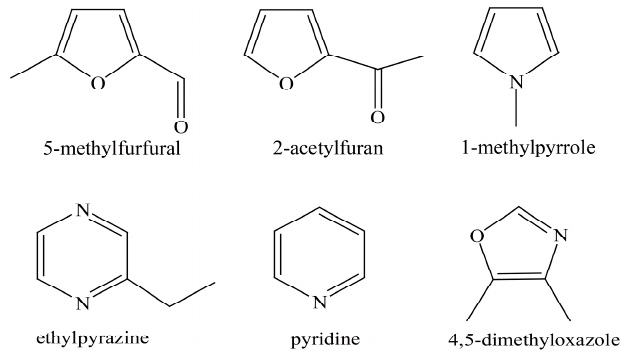
Figure 2. Structures of some representative compounds identified in the glucose/glycine melanoidins [15].